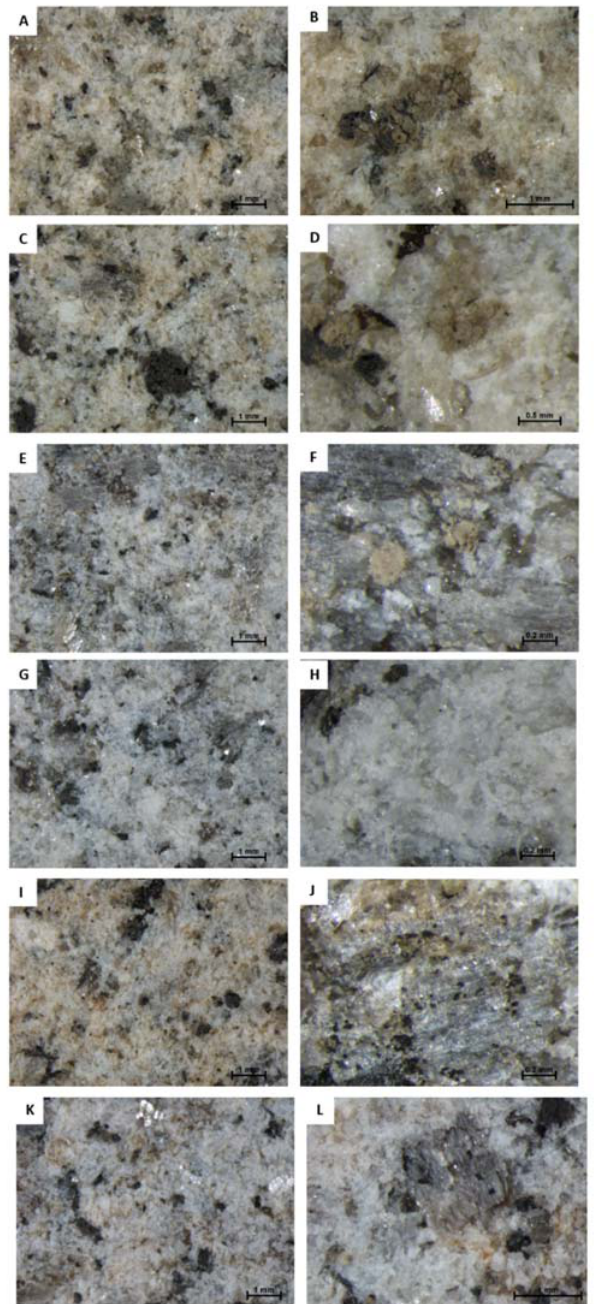
Figure 2. Micrographs under stereomicroscopy of the treated surfaces with Nd:YAG at different wavelengths-355 nm ( A – D ); 532 nm ( E – H ) and 1064 nm ( I – L ). Fluences were 2 J · cm − 2 ( A , B , E , F , I , J ) and 5 J · cm − 2 ( C , D , G , H , K , L ).